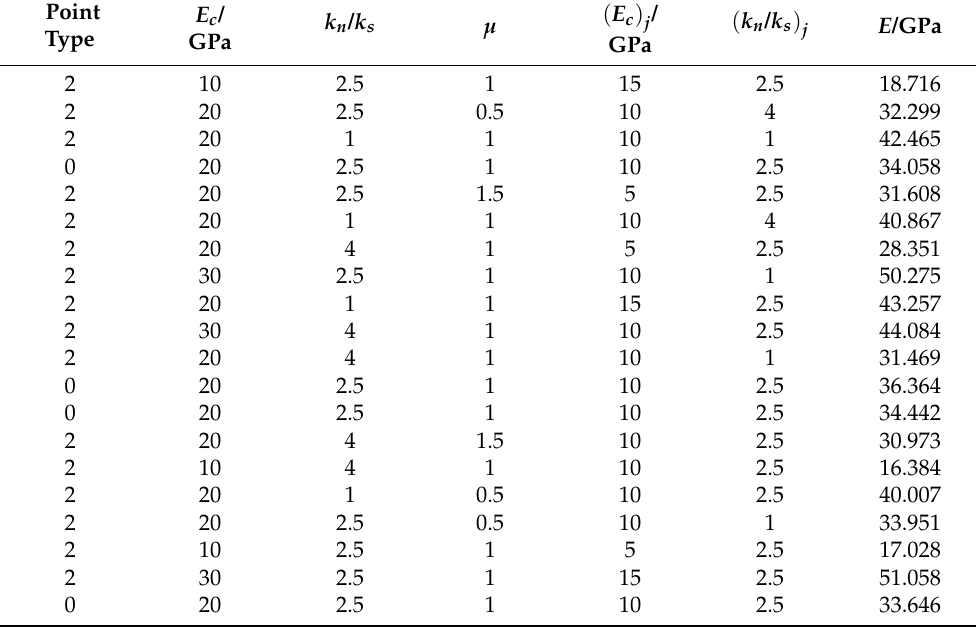
Table 10. BBD test table of the elastic